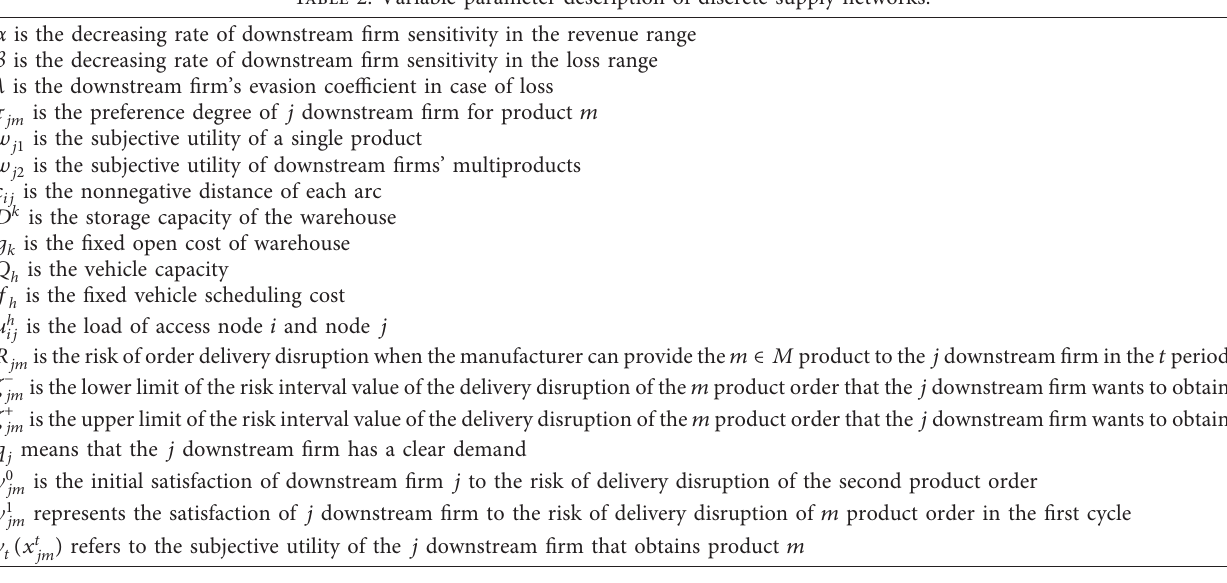
Table 2: Variable parameter description of discrete supply networks.